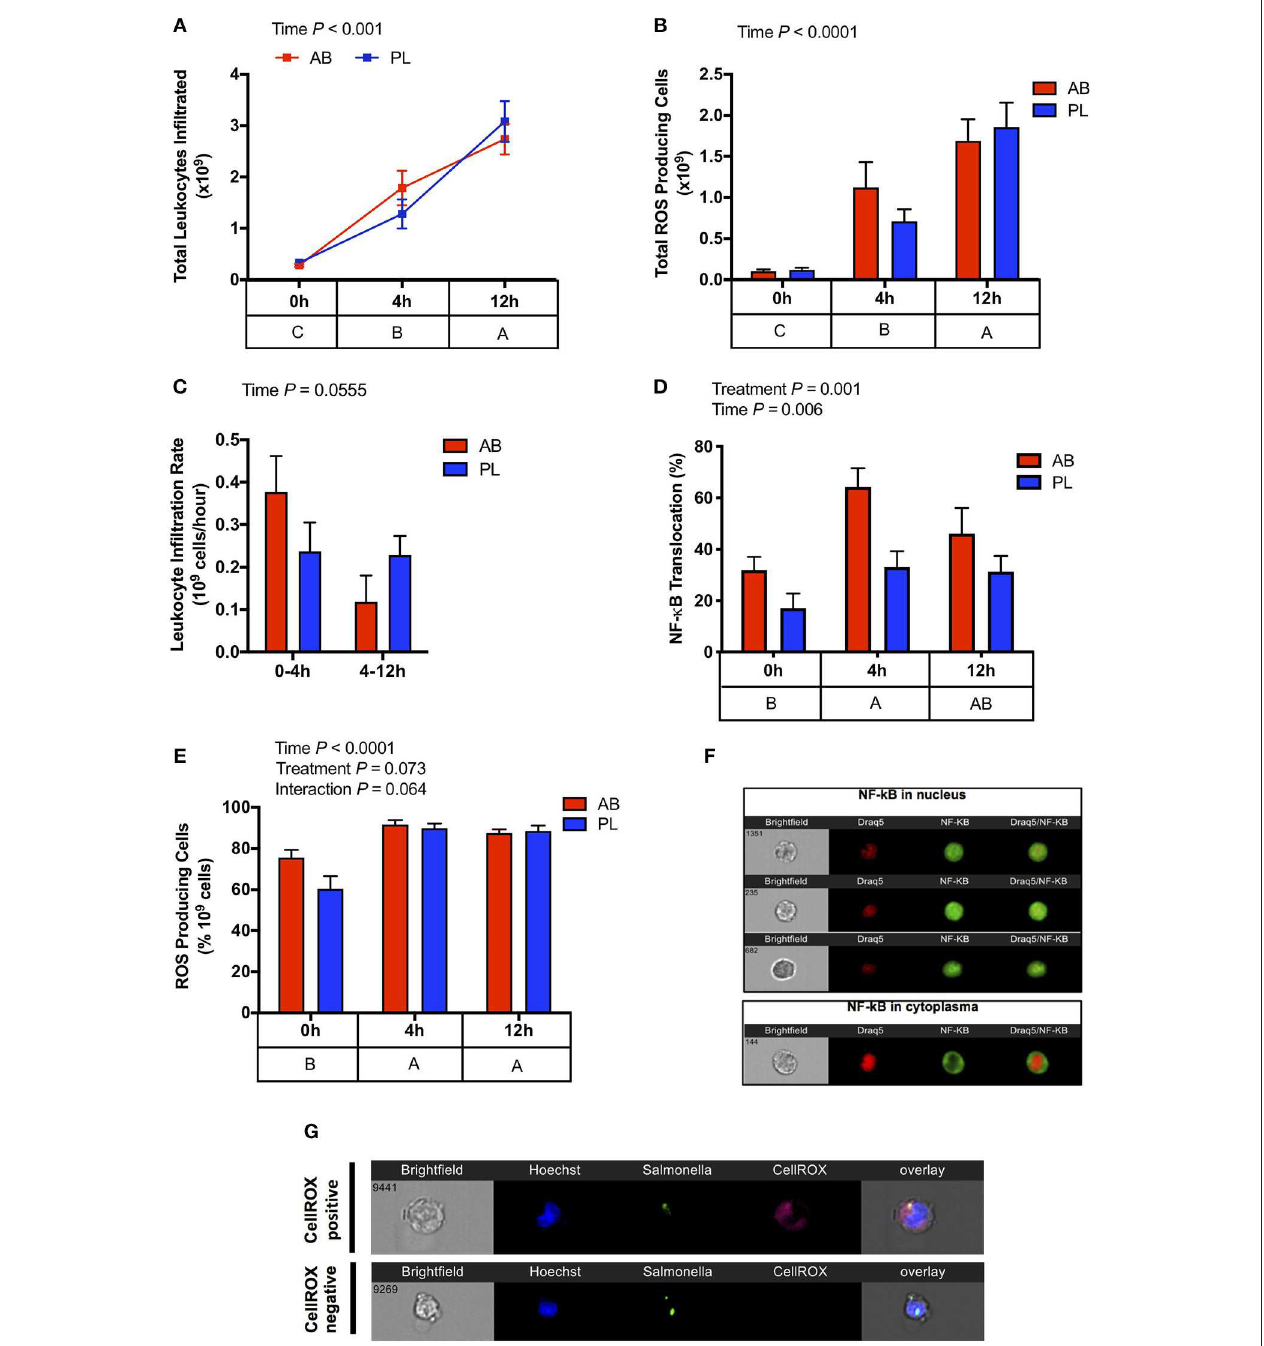
FIGURE 4 | Antibiotic (AB) exposure induced a stronger leukocyte activation against an intraperitoneal Salmonella challenge in comparison to pigs treated with placebo (PL). (A) Total leukocyte infiltration (Two-way ANOVA Treatment P = 0.870, Time P < 0.001, Interaction P = 0.306) and (B) and total reactive oxygen species producing cells (Two-way ANOVA Treatment P = 0.963, Time P = 0.009, Interaction P = 0.845) increased progressively 4 and 12h post IP Salmonella challenge. (C) Leukocyte infiltration tended to reduce over time (Two-way ANOVA Treatment P = 0.823, Time P = 0.055, Interaction P = 0.072). (D) Leukocyte activation detected through NF- κ B nuclear translocation was higher in the AB treated pigs compared to PL post Salmonella challenge, and increased over time (Two-way ANOVA Treatment P = 0.001, Time P = 0.006, Interaction P = 0.410). (E) Exposure of peritoneal leukocytes in vitro to heat-killed Salmonella resulted in increased ROS production in both the AB and PL treated pigs between 0 and 4h and 0 and 12h with a tendency of AB treated piglets to have higher ROS production (Two-way ANOVA Treatment P = 0.073, Time P < 0.01, Interaction P = 0.064). n = 4–5/treatment/time. (F) Representative images of neutrophil NF- κ B nuclear translocations (G) Representative images of ROS production in response to in vitro stimulation. The main effect of time is displayed below each figure and those PND not sharing a common subscript differ significantly.